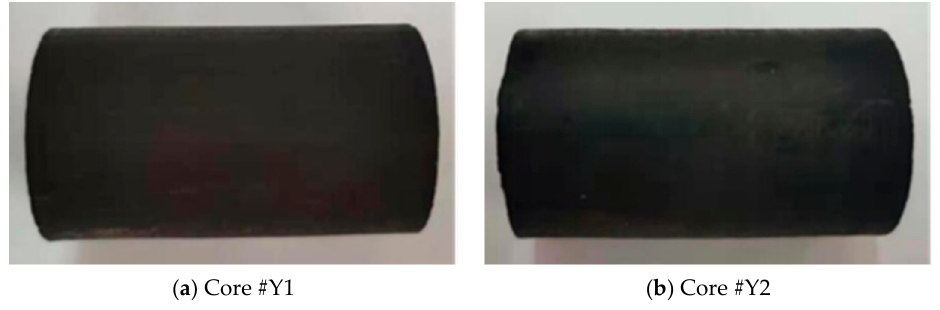
Figure 2. Chang 7 formation core samples used in this study. Table 1. Physical properties of the core samples. Core No.